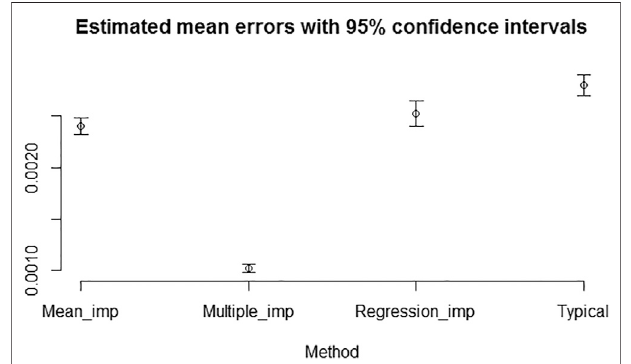
FIGURE 6 | Estimated mean errors with 95% con fi dence intervals for computing Brier scores with 25% individual missing values introduced not at